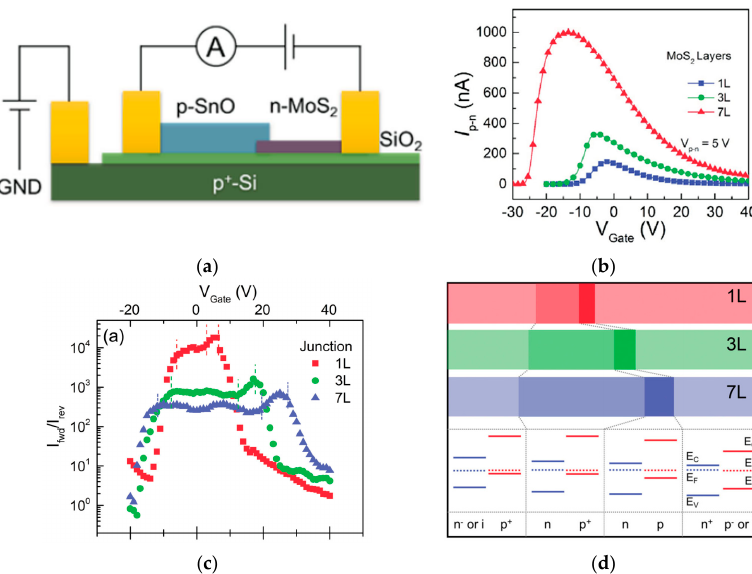
Figure 9. Rectification effect in MoS 2 /SnO p–n diodes. ( a ) Schematic illustration for the setup of gate-tunable I–V characterization; ( b ) Anti-ambipolar transfer curves for all three junctions; ( c ) Rectification ratio of the 1 L, 3 L, and 7 L heterojunctions as a function of gate voltage; ( d ) Illustration of the band alignments according to the change in rectification ratio (Zhenwei Wang et al. [110]).